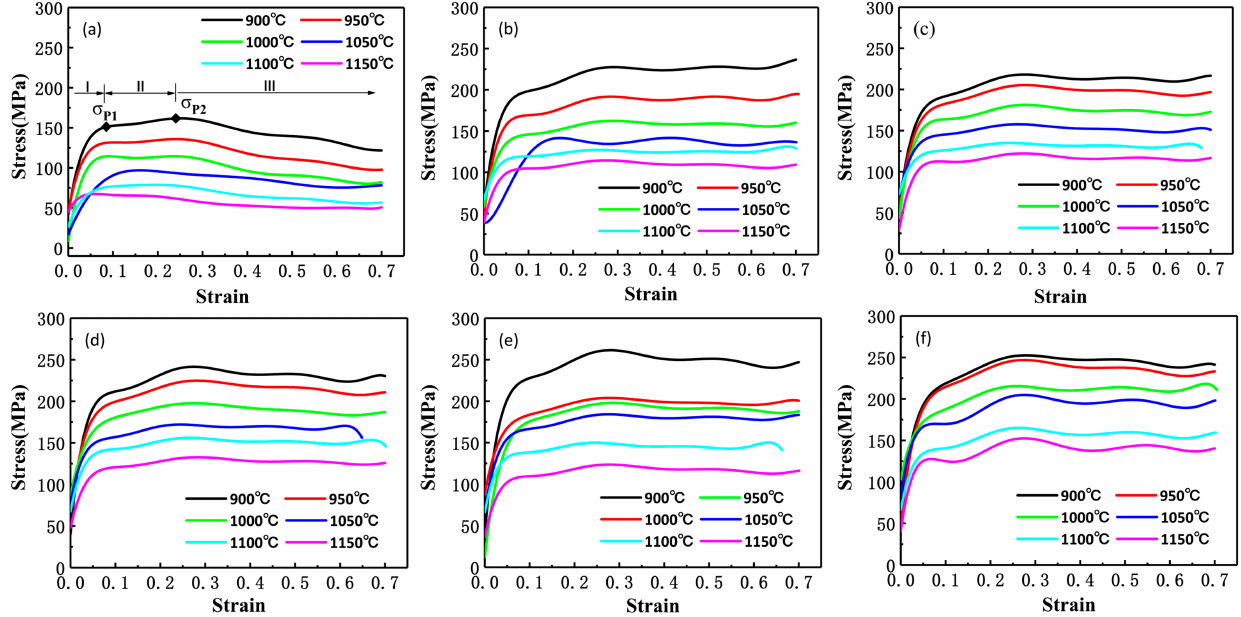
Figure 4. True stress–strain curves at various deformation parameters: ( a ) 0.1 s − 1 , ( b ) 1 s − 1 , ( c ) 2.5 s − 1 , ( d ) 5 s − 1 , ( e ) 10 s − 1 , and ( f ) 20 s − 1